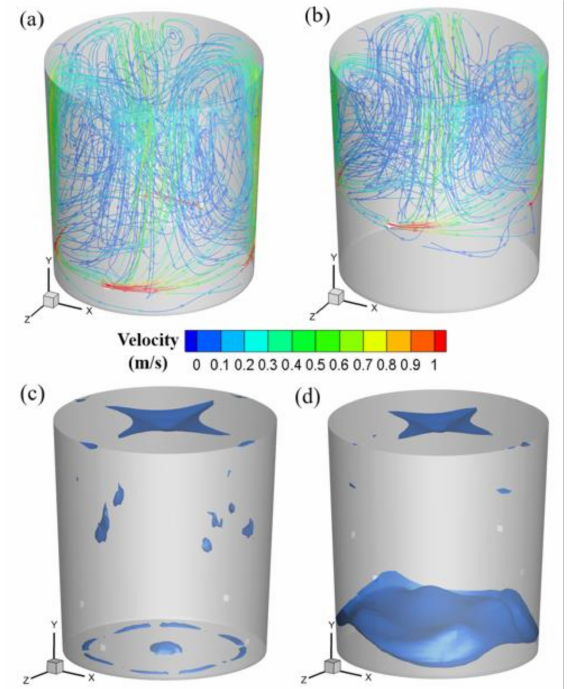
Figure 16. Streamlines and stagnant regions of water in model ladle with four side plugs at different heights under the flow rate of 1.8 m 3 /h after blowing 60 s: ( a ) streamline at 116 mm; ( b ) streamline at 450 mm; ( c ) stagnant at 116 mm; ( d ) stagnant at 450